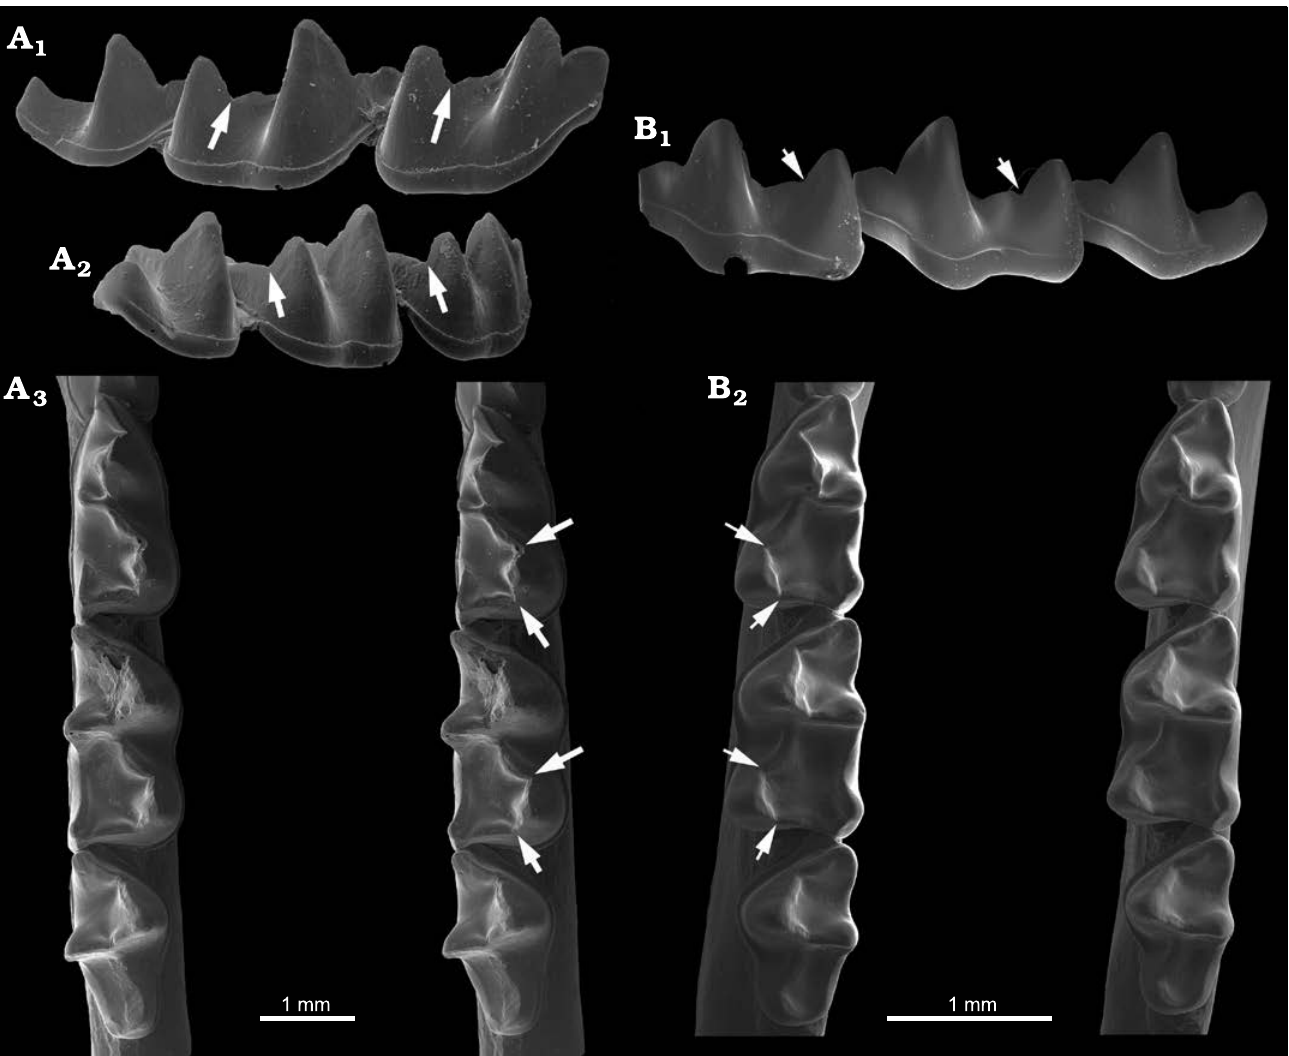
Fig. 9. Molars of Recent phyllostomid bats, showing carnassiform notches and accessory troughs in the talonid basins of m1 and m2. A . Glyphonycteris daviesi (Hill, 1964) (USNM 364266) from Peru. Right lower molars in anterolabial view (A 1 ) showing the notches in the cristids obliqua (arrows; note that the entoconids are partly visible in the background immediately behind the cristid obliqua notch in each molar); posterolabial view (A 2 ) showing the notches in the postcristids (arrows), and occlusal view (A 3 , stereopair) showing the talonid notches and adjacent troughs (arrows). Note also the carnassial notch and slit in the mesiodistally-oriented paracristid of the m1 trigonid. B . Trinycteris nicefori (Sanborn, 1949) (AMNH 184558) from Panama. Left lower molars in anterolabial view (B 1 ) showing carnassiform notches in the cristids obliqua of m1–m2, entoconid in background partly obscures the notch in m1, and occlusal view (B 2 , stereopair) showing carnassiform notches and accessory troughs in m1–m2